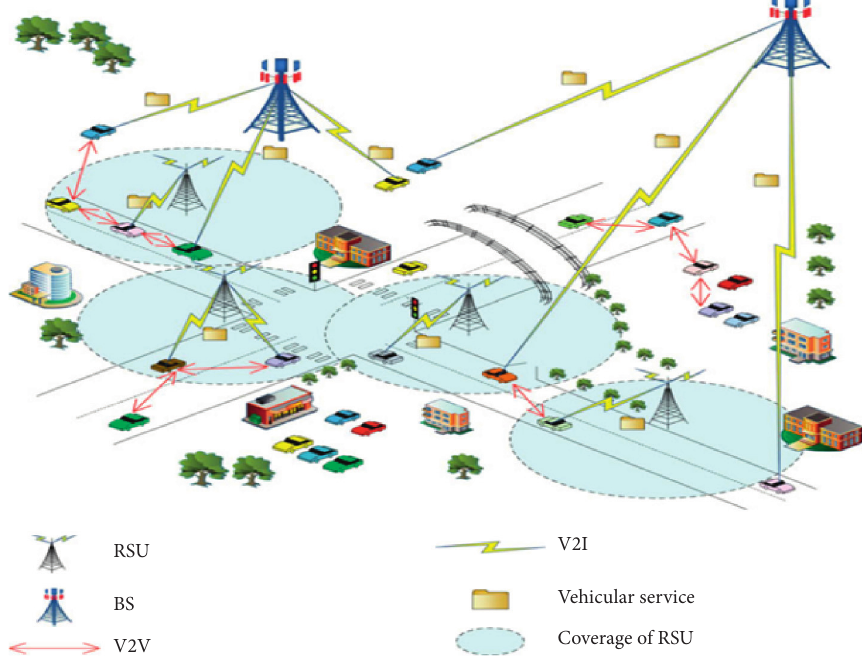
Figure 1: Vehicular Ad-hoc Network (VANET) architecture